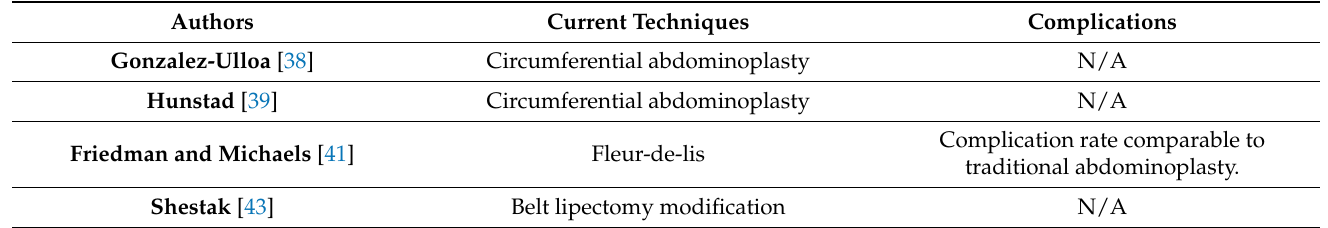
Table 2. Current techniques and